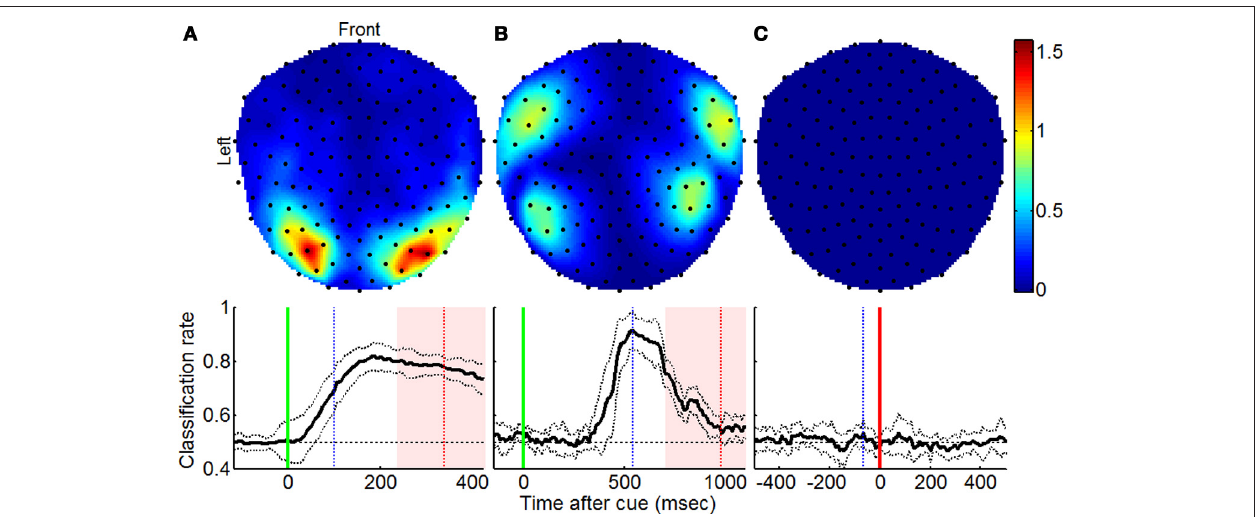
FIGURE 1 | Regions contributing to increased classification accuracy using Fisher discriminant analysis. Top row shows topographic plots indicating sensors at which amplitude-based signal classification was most notable as described by Equation (1) for (A) visually and (B) aurally cued experiments and the (C) memorized instruction experiment. Bottom row